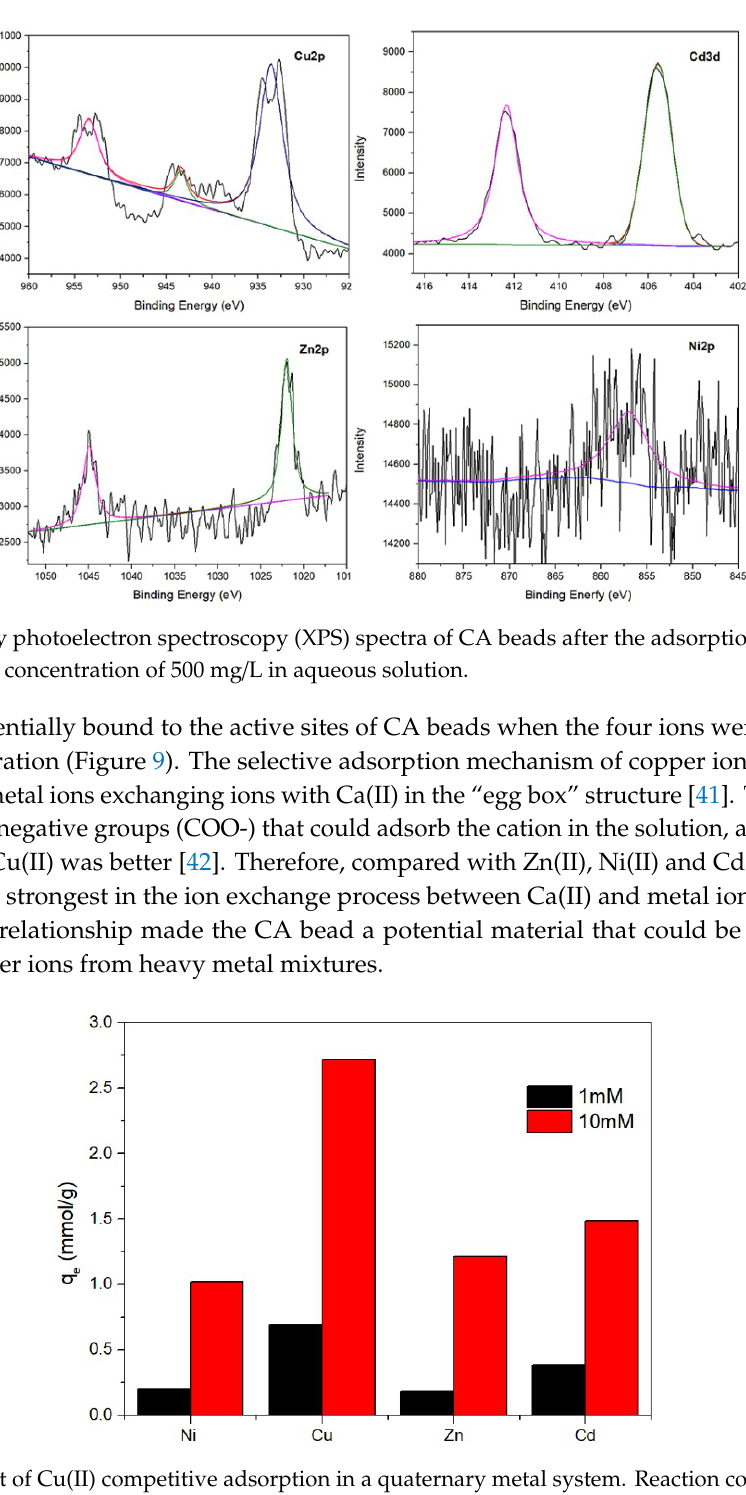
Figure 7. FTIR images of CA beads before and after the adsorption.